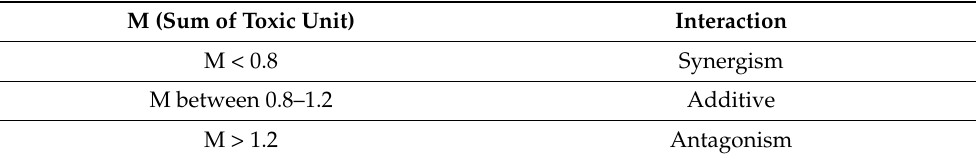
Table 1. Sum of Toxicity Unit values representing the interaction existing between mixture compound [40,41].